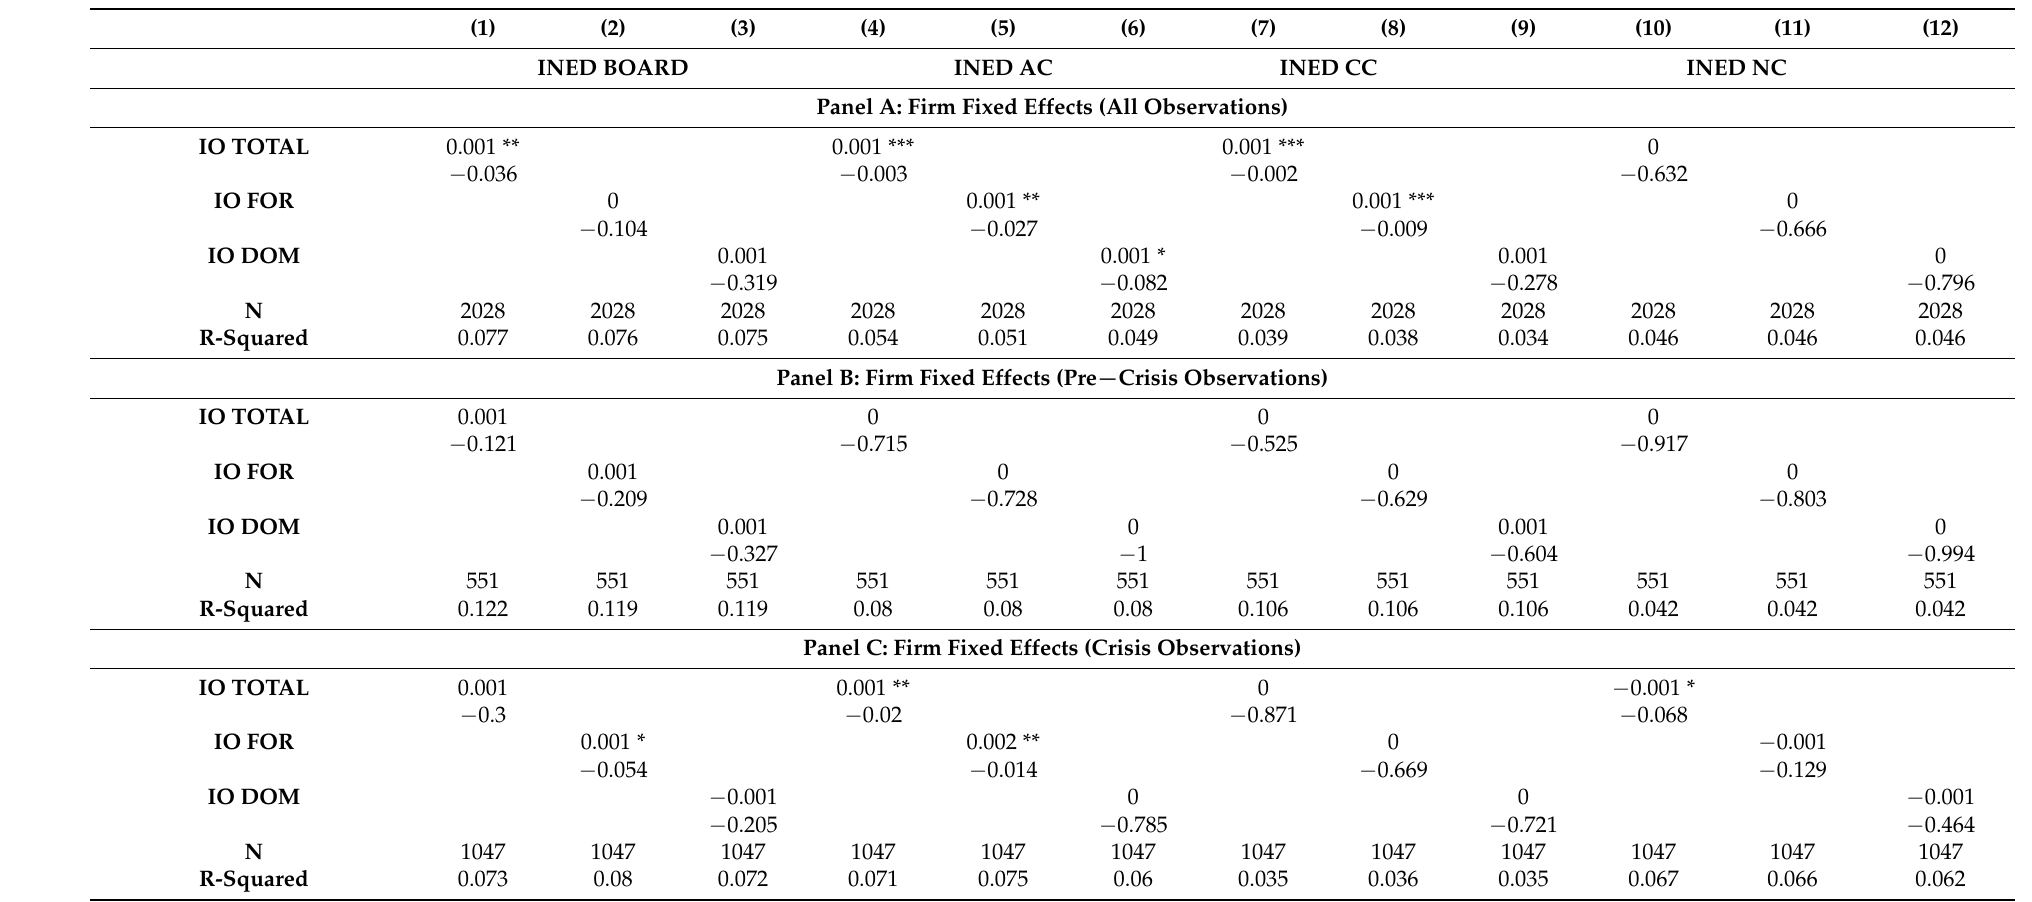
Table 3. Institutional ownership and board